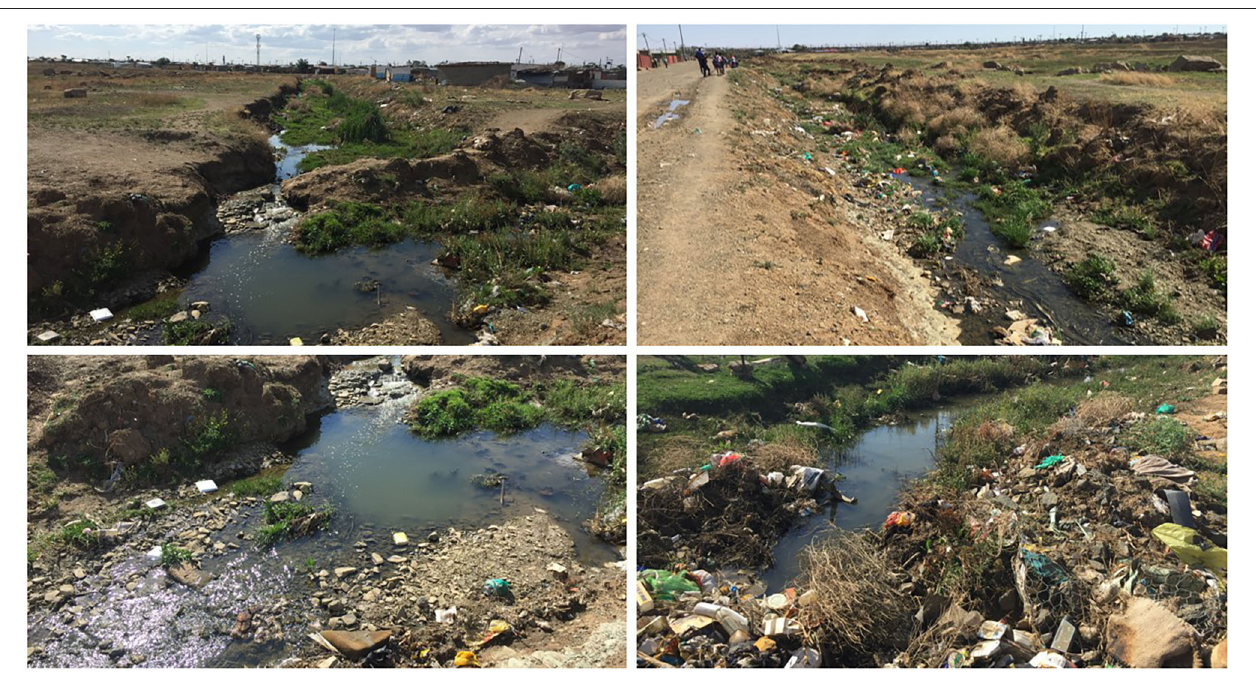
FIGURE 3 | Navigating the hazardous landscapes in low-income communities of